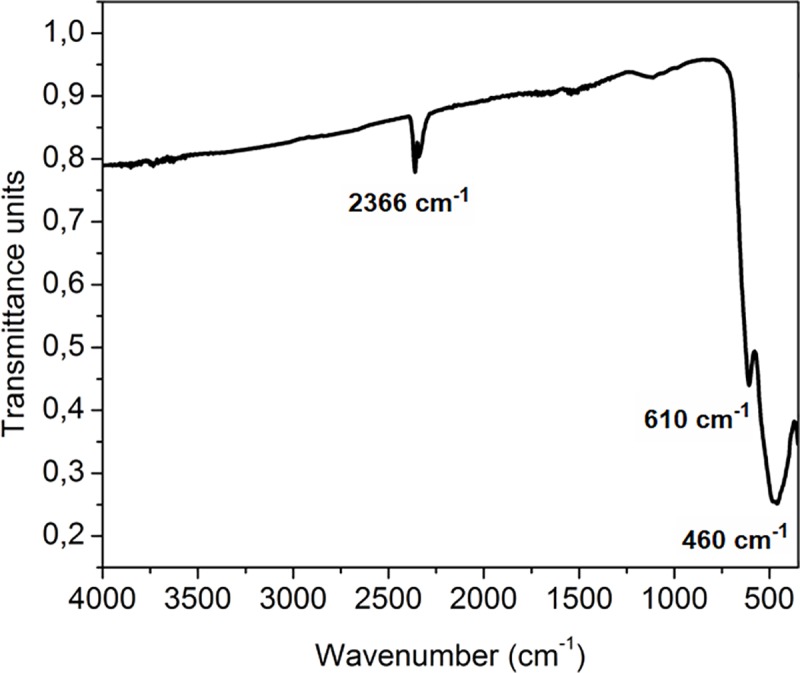
FTIR spectrum of MnCO2O4 nanoparticles in the spectrum range from 400 to 4000 cm-1.